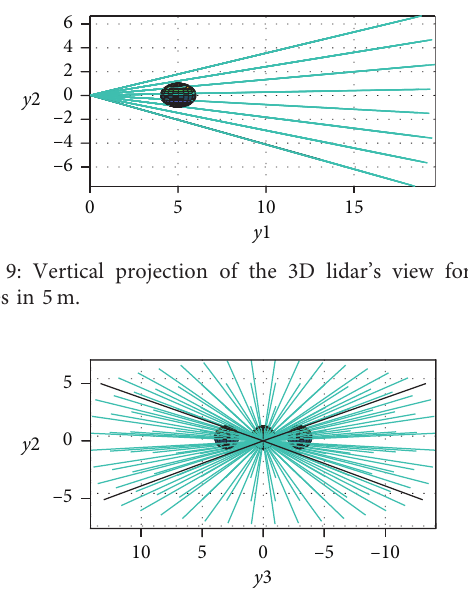
Figure 12: Front projection of the 3D lidar’s view for five obstacles in 15m.